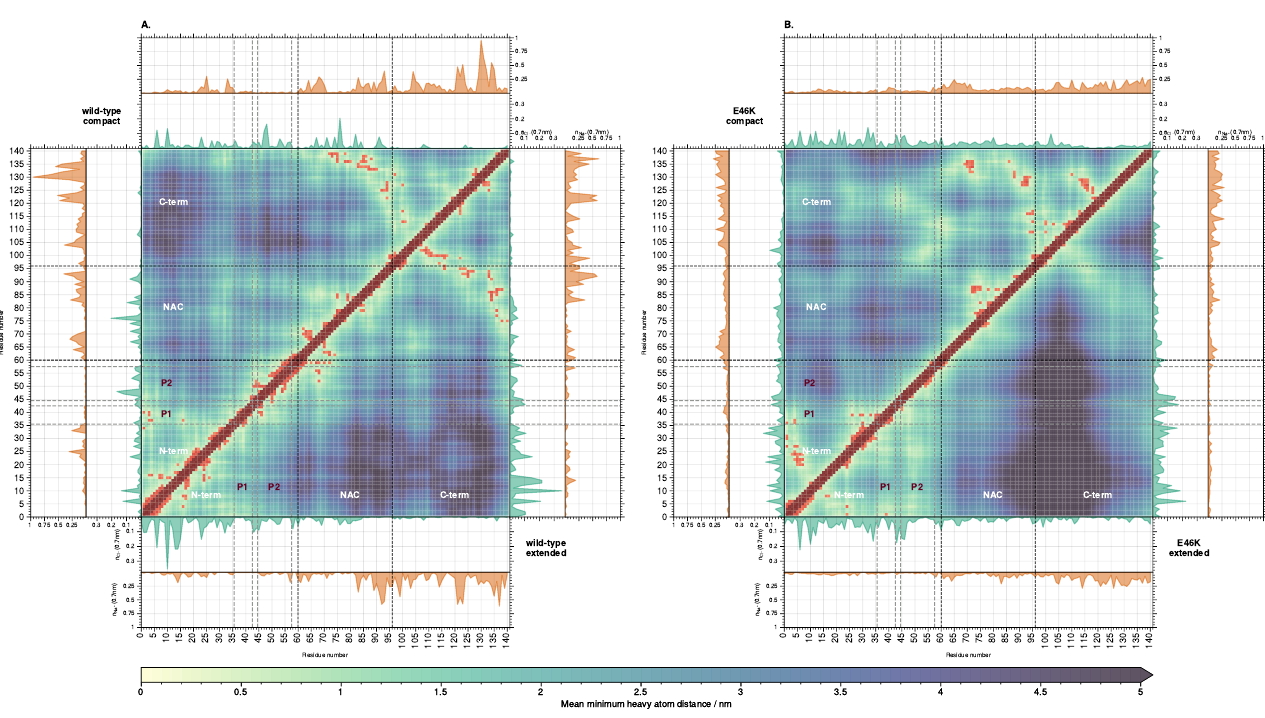
Figure 4. Residue distance map of AS for wild-type compact ( A , upper triangle) and extended ( A , lower triangle), as well as E46K-AS compact ( B , upper triangle) and extended ( B , lower triangle) conformations. Red points mark contacts (mean distance ≤ 0.5nm). Insets show the mean number of chloride (green) and sodium (orange) ions within a distance of